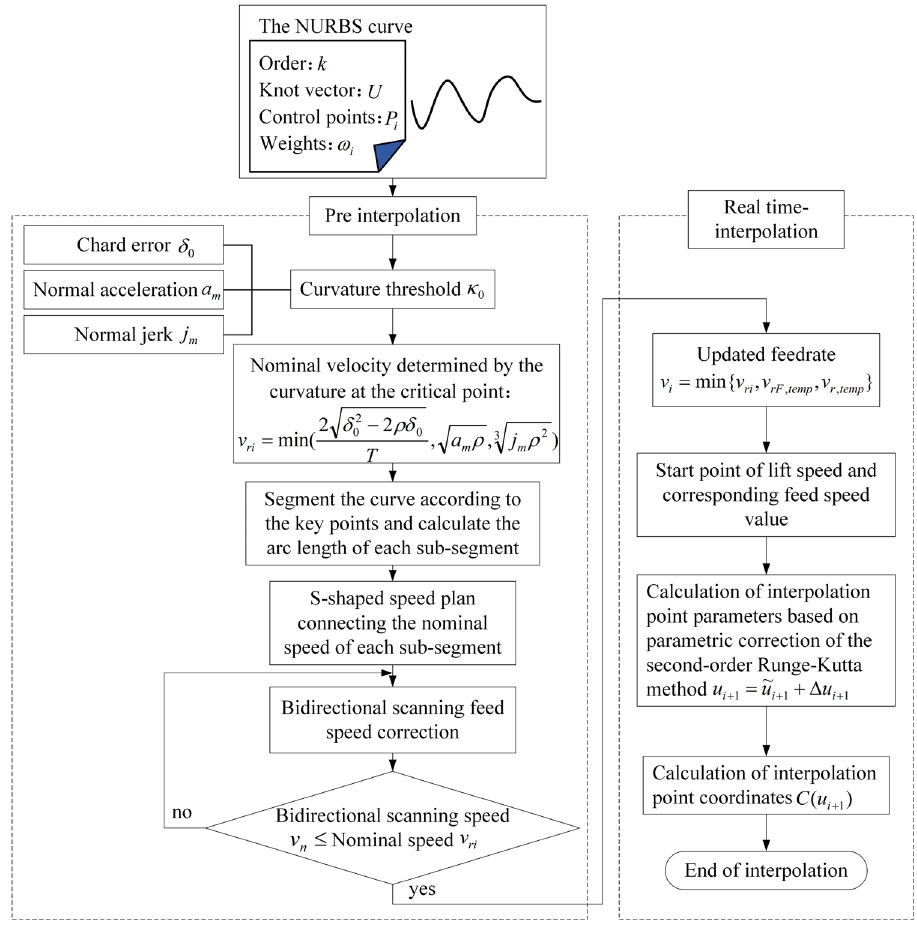
Figure 1. The overall process of the interpolation